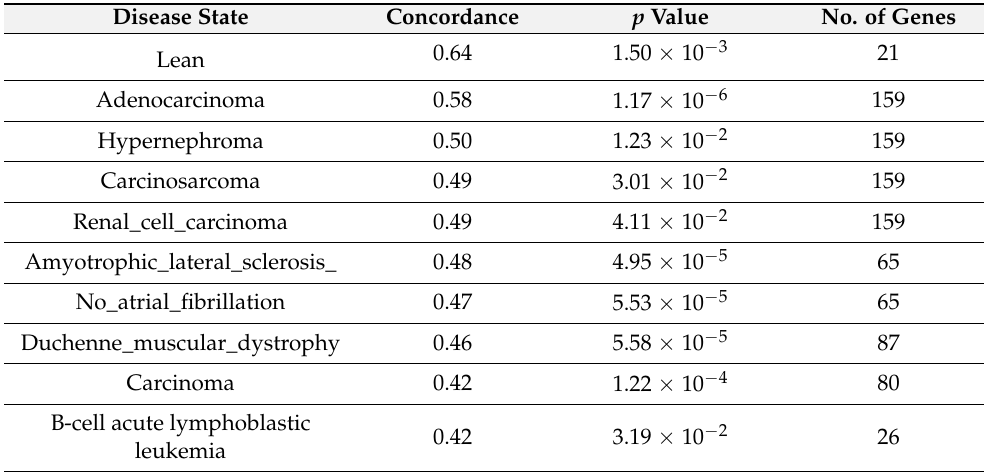
Table 3. The top 10 disease transcriptional signatures from iLINCS positively correlated with apoptotic CGN-related temporal expression changes.